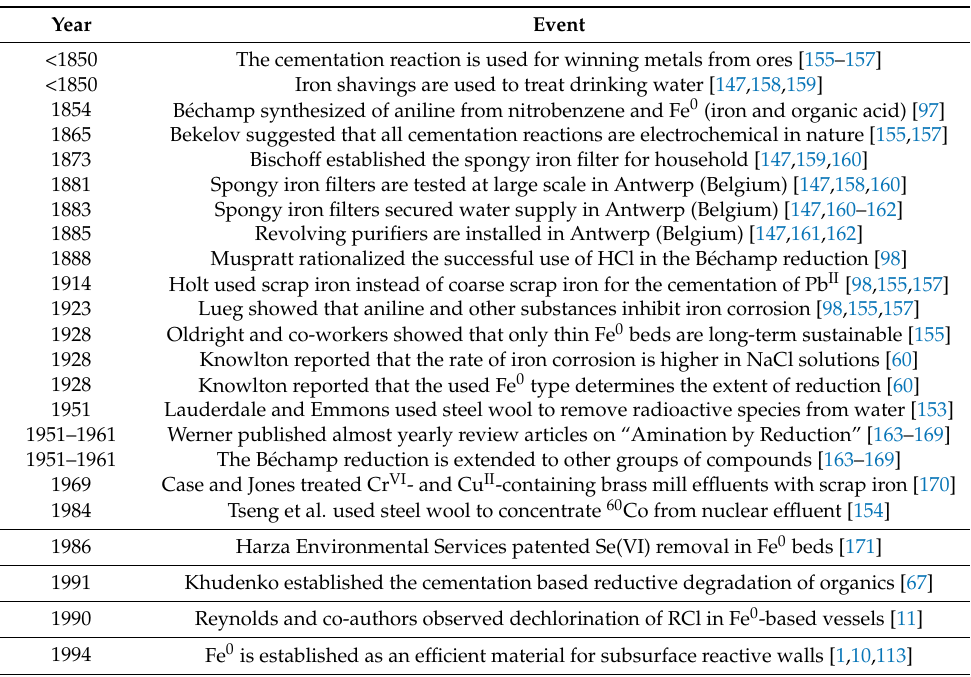
Table 2. Chronology of selected historical observations showing that the science of the Fe 0 /H 2 O system was explored before the 1970s while cementation studies and B é champs-like reactions have been carried out for more than 150